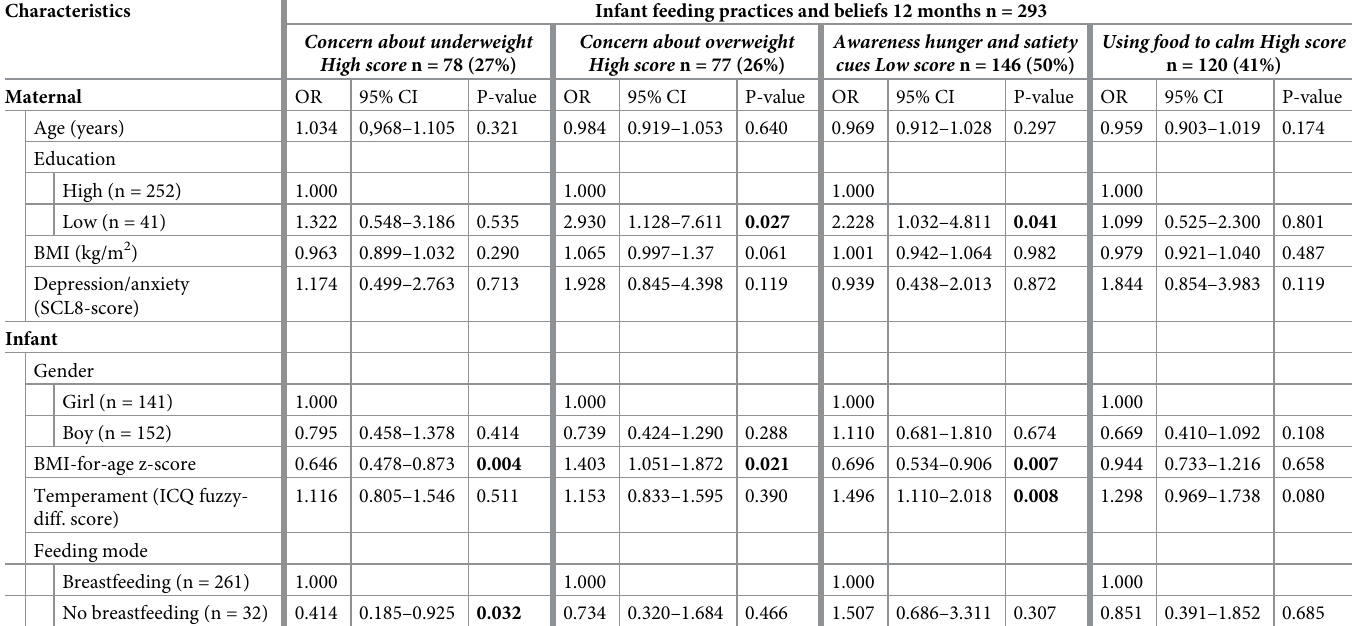
Table 3. Associations between maternal and child covariates at child age 5 months and maternal feeding beliefs and practices at child age 12 months estimated by multivariable logistic regression. Characteristics